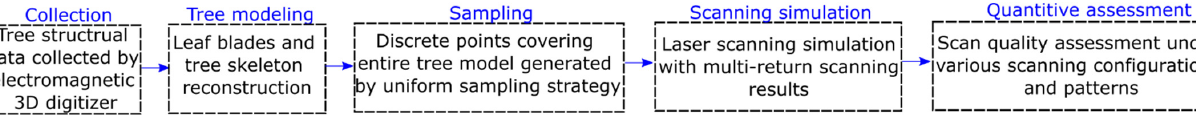
Figure 1. Flowchart illustrating the main steps of our mobile laser scanning simulation framework.